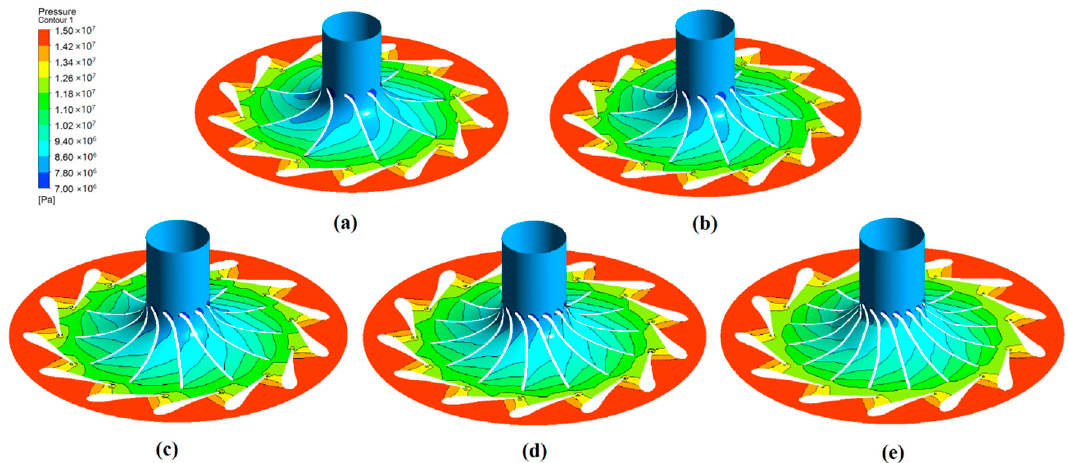
Figure 8. Pressure distribution at mid-span of SCO 2 : ( a ) solidity 7.96; ( b ) solidity 9.95; ( c ) solidity 11.94; ( d ) solidity 13.93; ( e ) solidity 15.92.